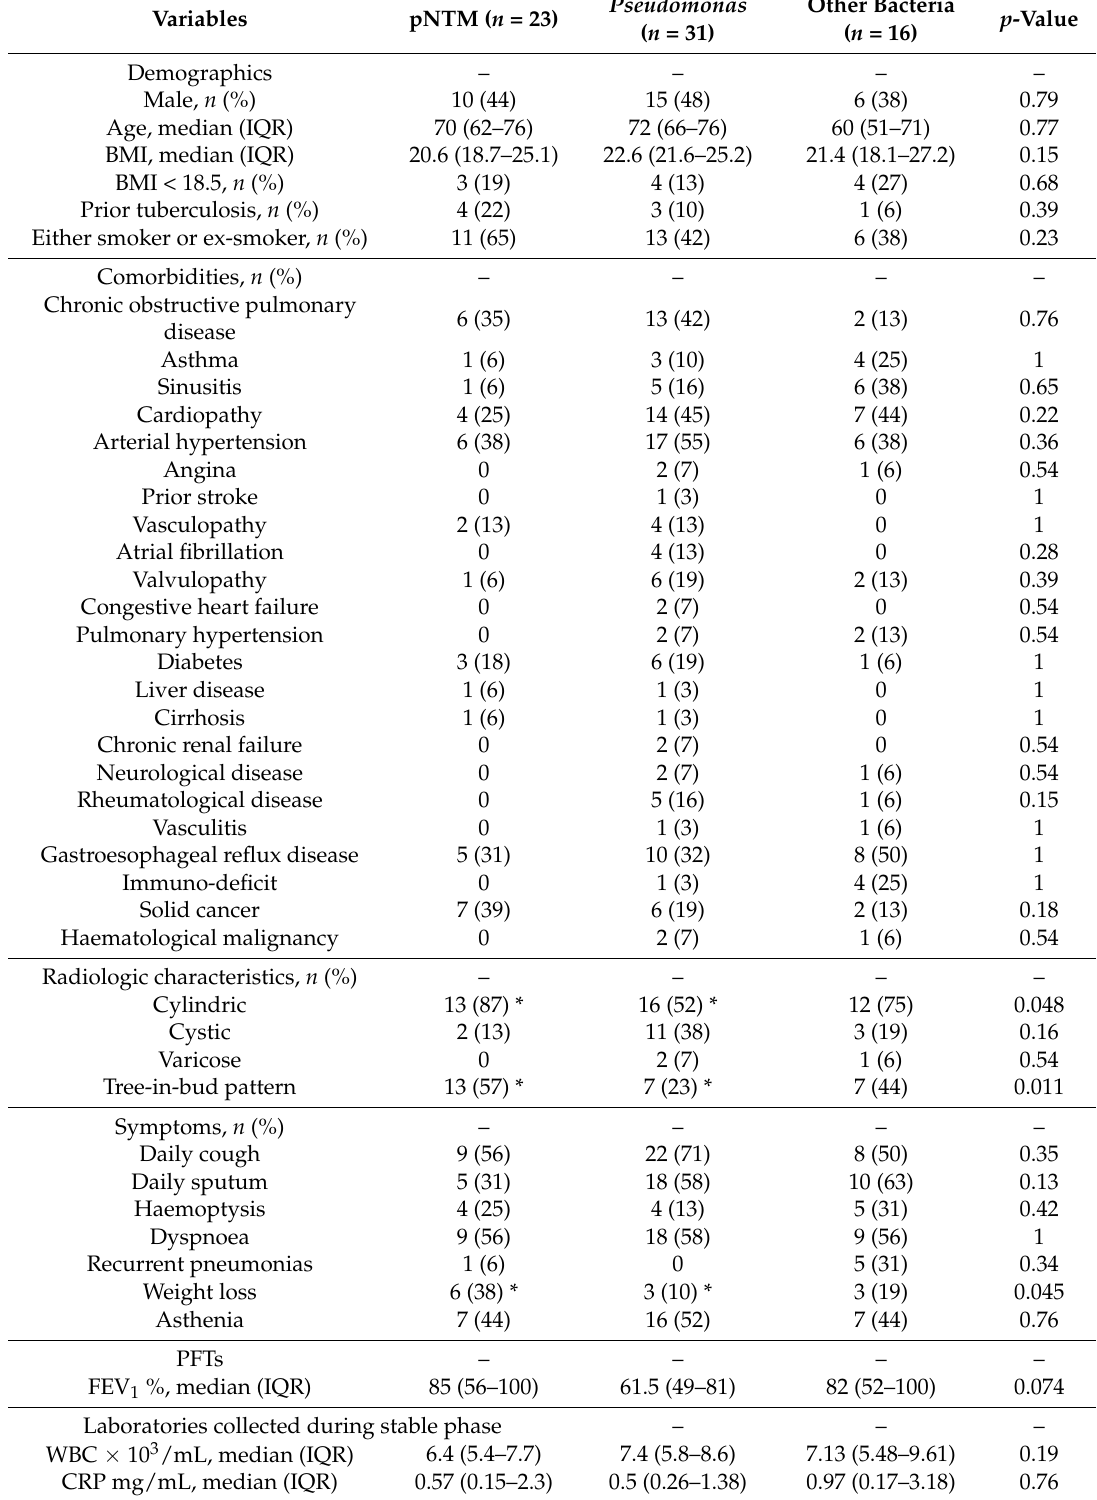
Table 2. Demographics, comorbidities, radiological characteristics, symptoms, pulmonary function and laboratory data according to the three study groups: pulmonary non-tuberculous mycobacteria disease (pNTM); chronic infection with P. aeruginosa ( Pseudomonas ) and chronic infection with bacteria other than P. aeruginosa (other